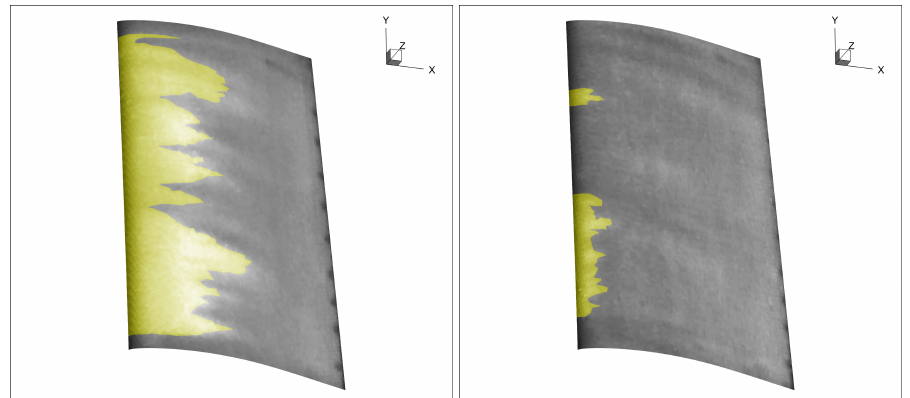
Figure 19. Thermal images from Figure 17 after transition-detection procedure. Left : Thermographic image. Right : x-y-plot of temperature.